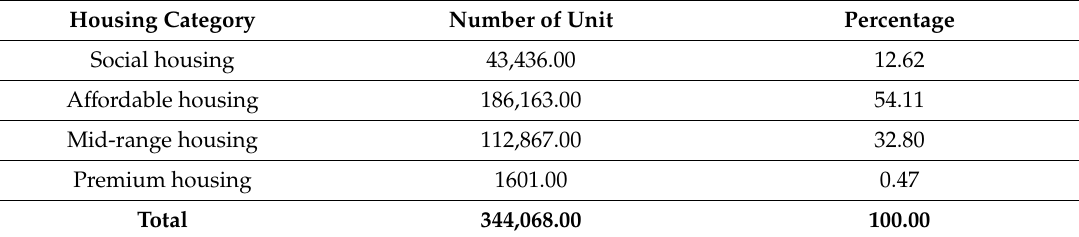
Table 1. Housing demand in Kigali city from 2012 to 2020. Data source: adapted from City of Kigali and Nkubito